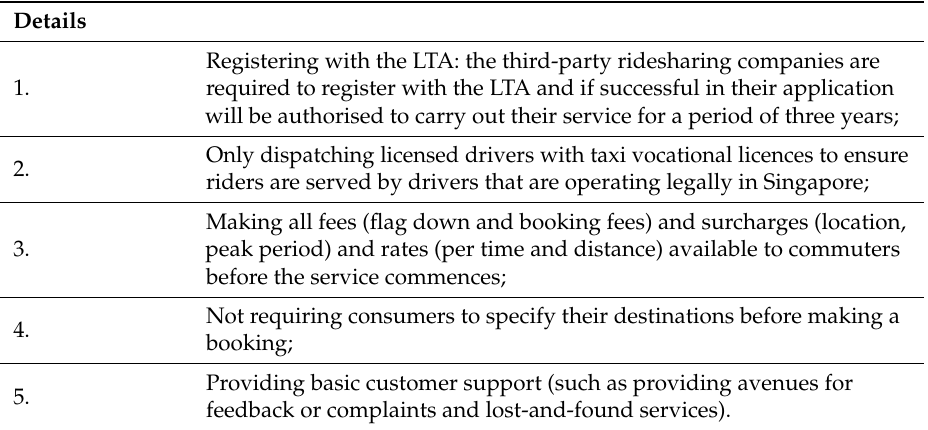
Table 2. Regulations released in 2014 about third-party ridesharing